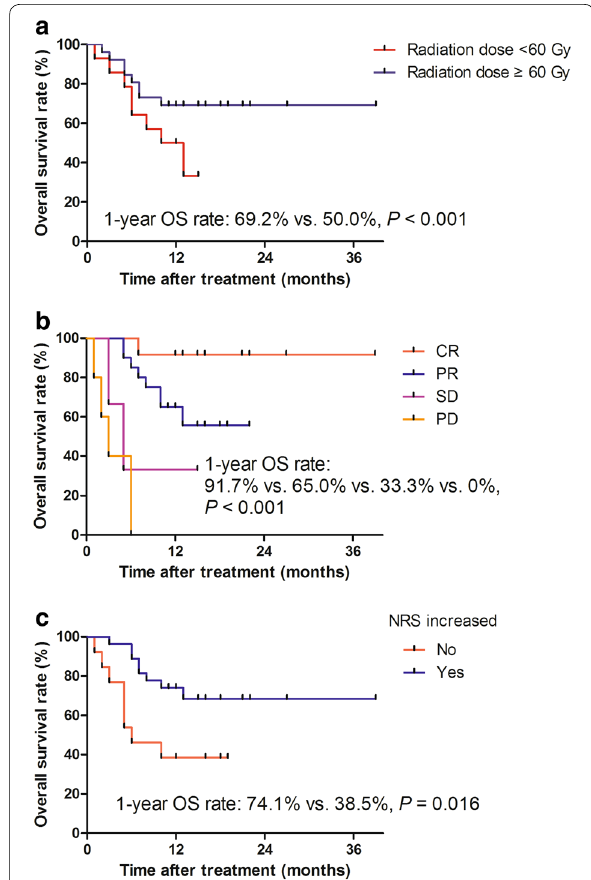
Fig. 1 Kaplan–Meier overall survival (OS) curves for esophageal squamous cell carcinoma patients with malignant fistula categorized by radiation dose, response to treatment, and increased nutrition risk screening (NRS) score or not. a OS curves for patients receiving different doses of radiation. b OS curves for patients with different responses to treatment. c OS curves for patients who experienced an increase of NRS score or not. CR, complete response; PR, partial response; SD, stable disease; PD, progressive